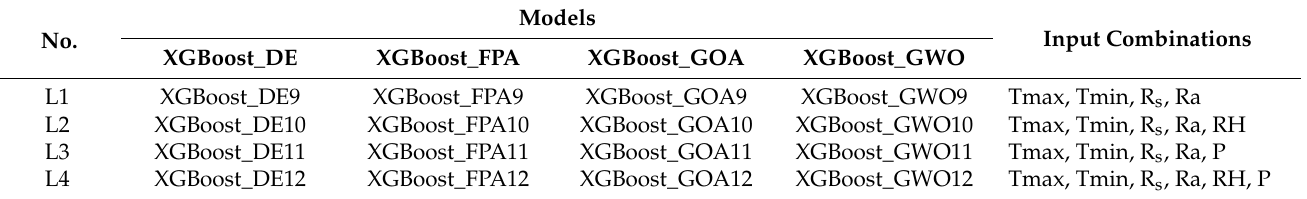
Table 3. The input combinations based on ground weather station for four coupling models.